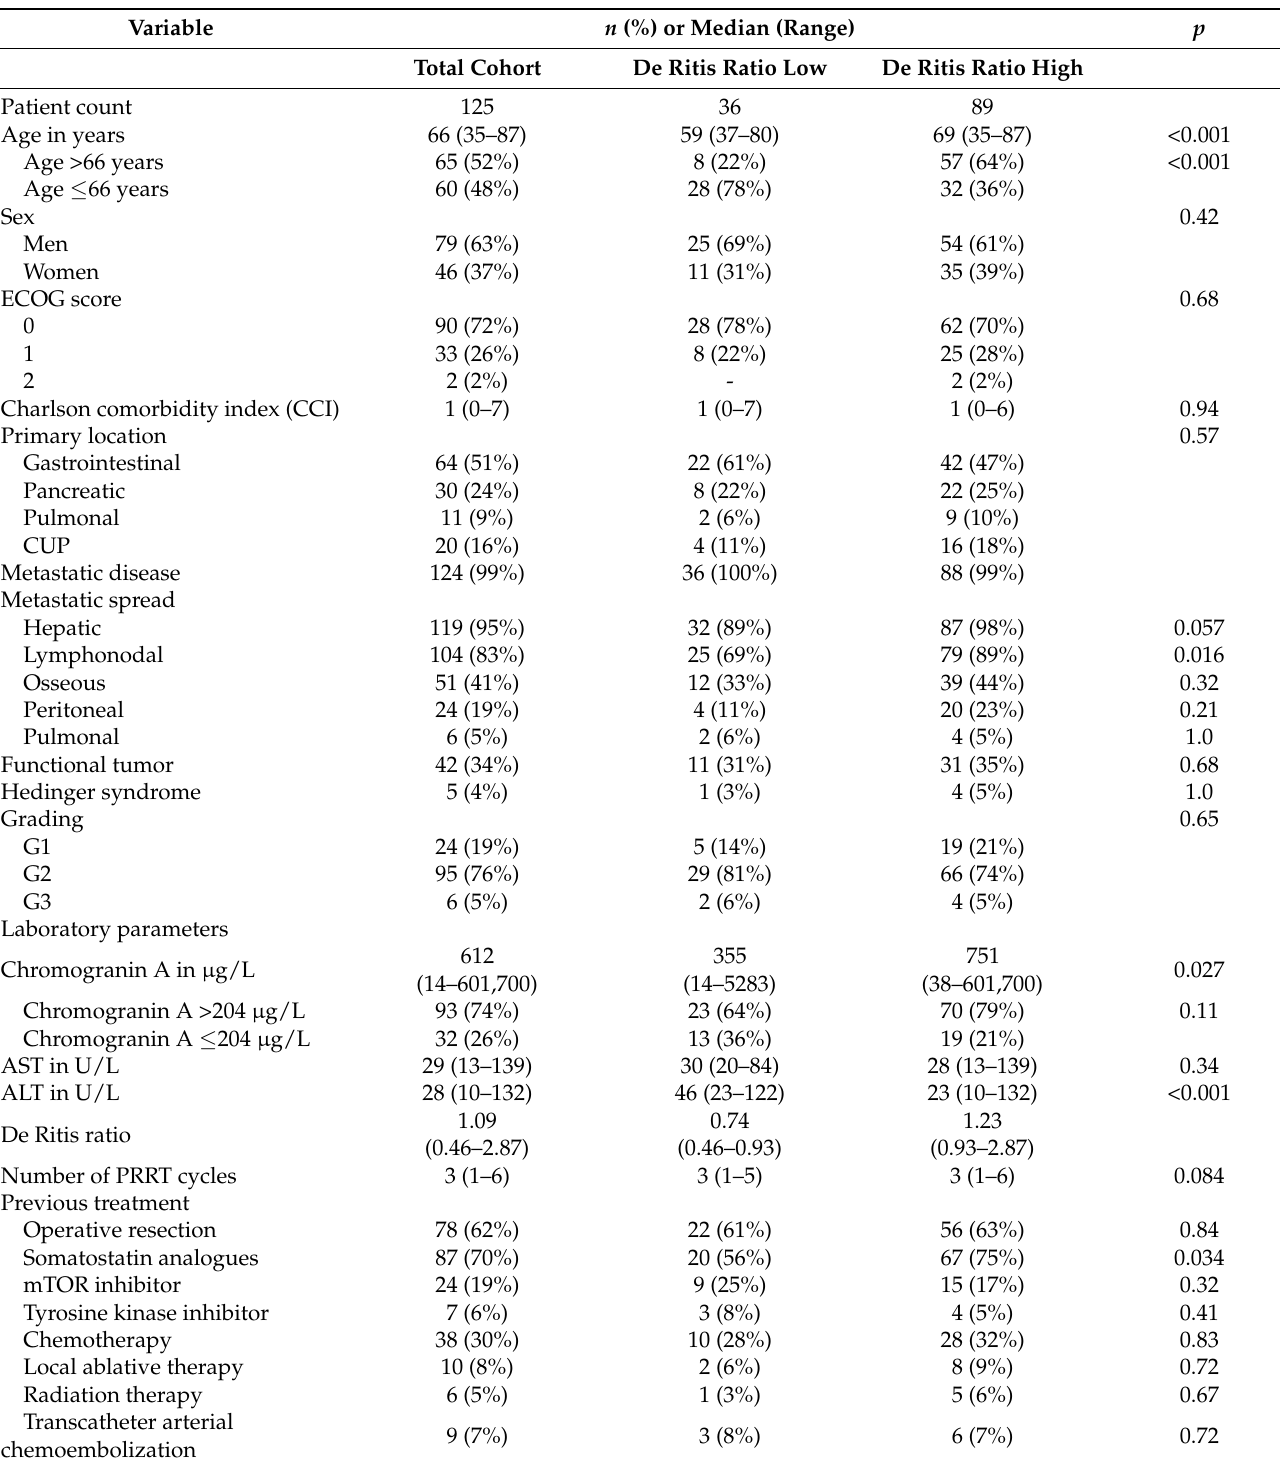
Table 1. Patient